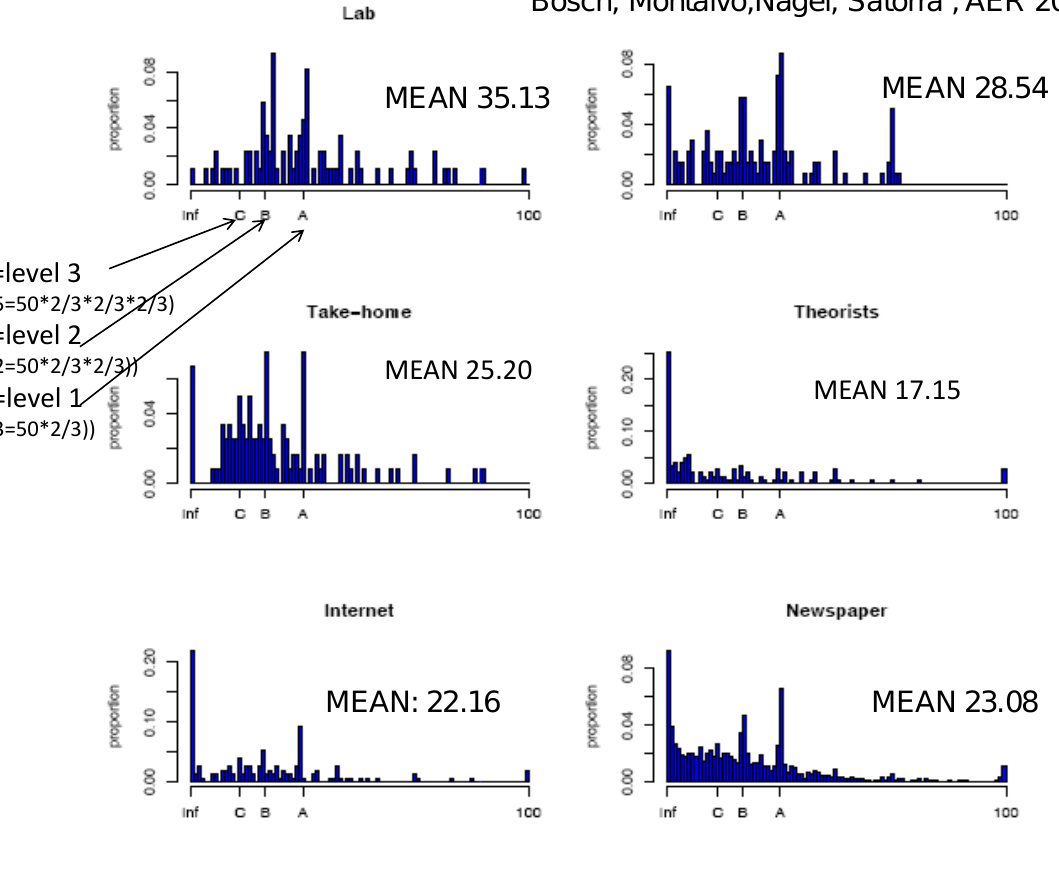
Figure 1: Relative frequencies of first-period choices reported in Bosch-Domenech et al.